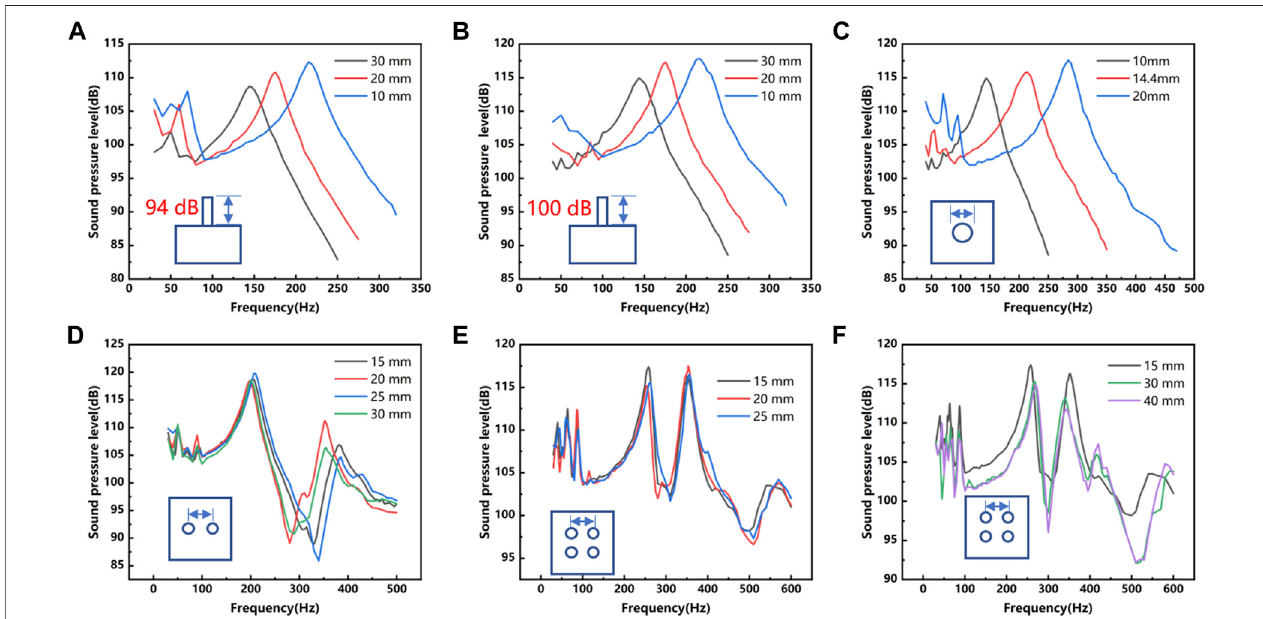
FIGURE 3 | Responses of sound pressure levels (SPLs) inside of modi fi ed resonators to sound waves (A,B) SPLs inside of the single tube Helmholtz resonators withdifferenttubelengthsunder94and100 dBincidentsoundwaves,respectively (C) SPLsinsideofthesingletubeHelmholtzresonatorswithdifferenttubediameters under100 dBincidentsoundwaves (D) SPLsinsideofdual-tubeHelmholtzresonatorswithdifferenttubespacingsunder100 dBincidentsoundwave (E,F) SPLsinside of four-tube Helmholtz resonators with different tube spacings under 100 dB incident sound waves.